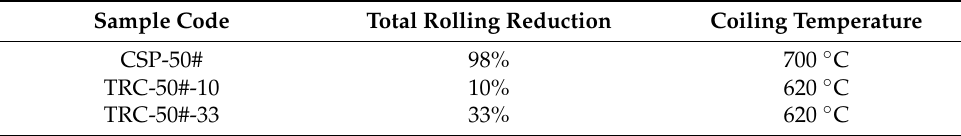
Table 3. Thermo-mechanical processing parameters of the experiment strips.